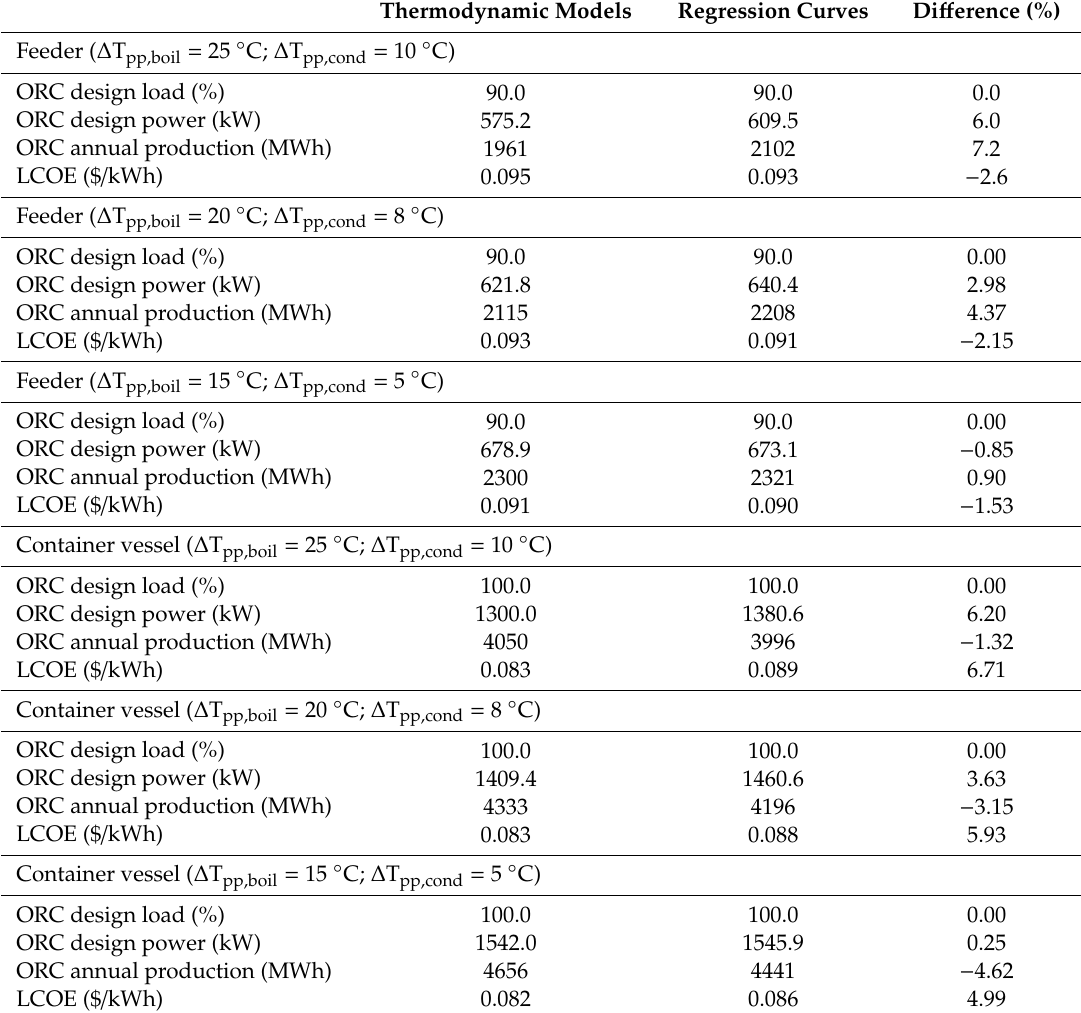
Table 8. Comparison between the solutions attained using the thermodynamic models and the regression curves (model #2): energy production maximization